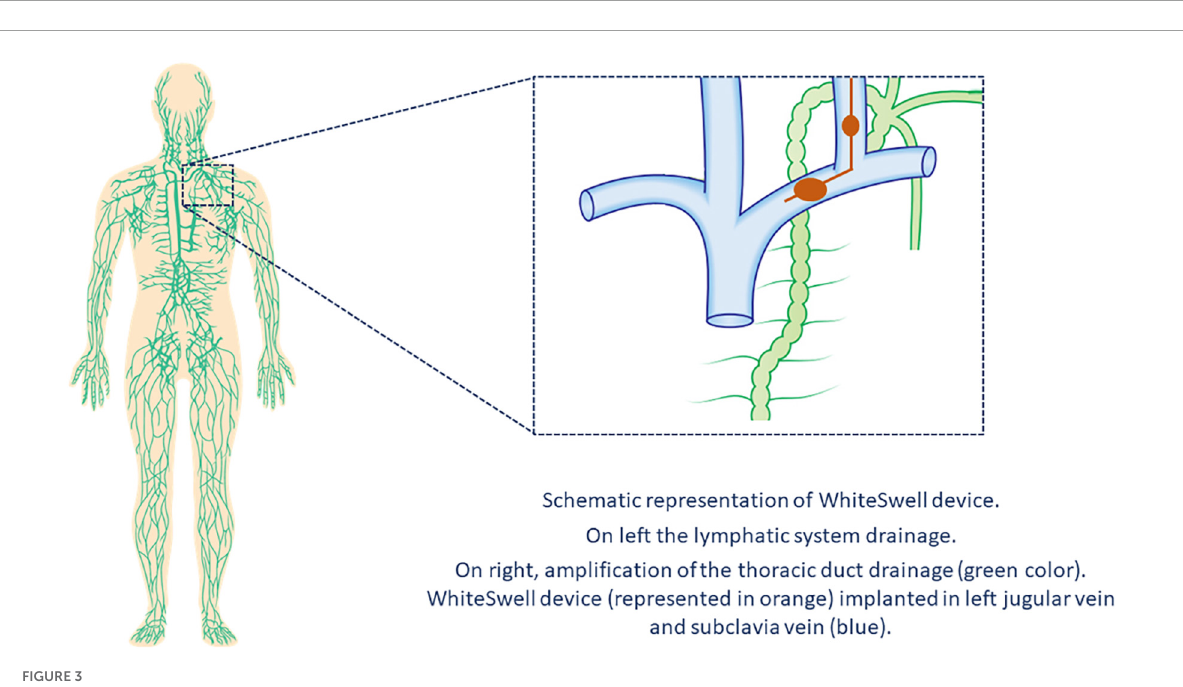
FIGURE3 Interstitial device. The WhiteSwell